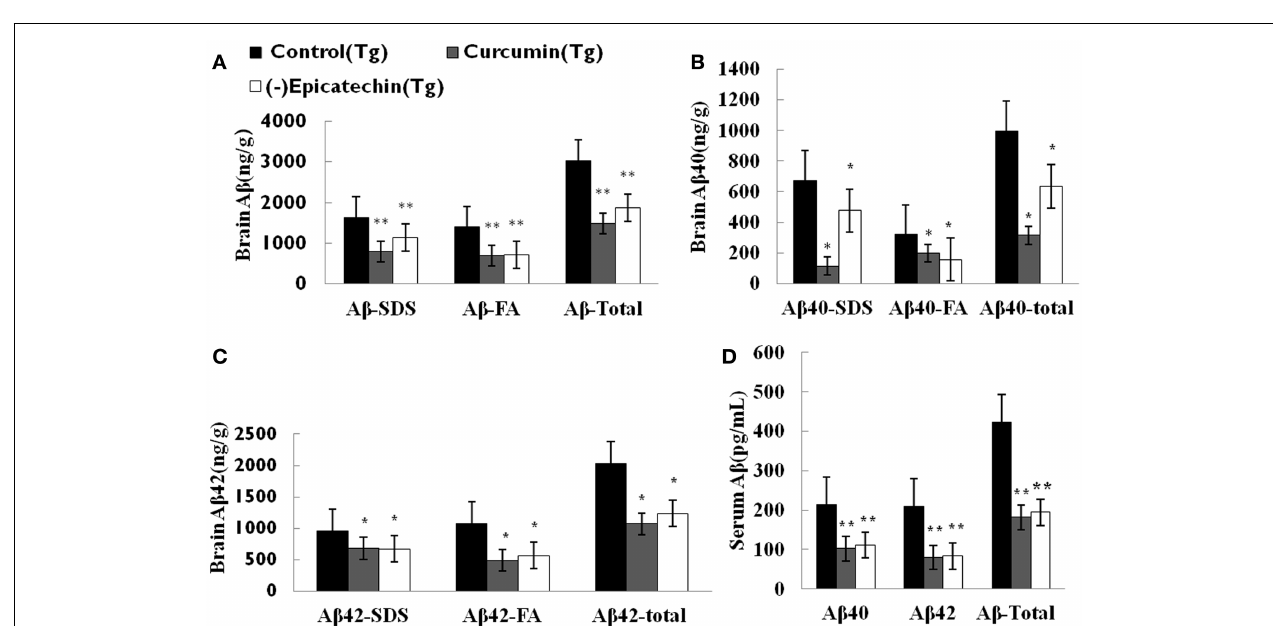
fraction (A β -FA) among groups. (B) Comparison of total A β 40, A β 40-SDS and A β 40-FA. (C) Comparison of total A β 42, A β 42-SDS and A β 42-FA. (D) Comparison of total A β , A β 40 and A β 42 in serum. * and ** denote P < 0.05 versus APP/PS1 transgenic mice fed with control